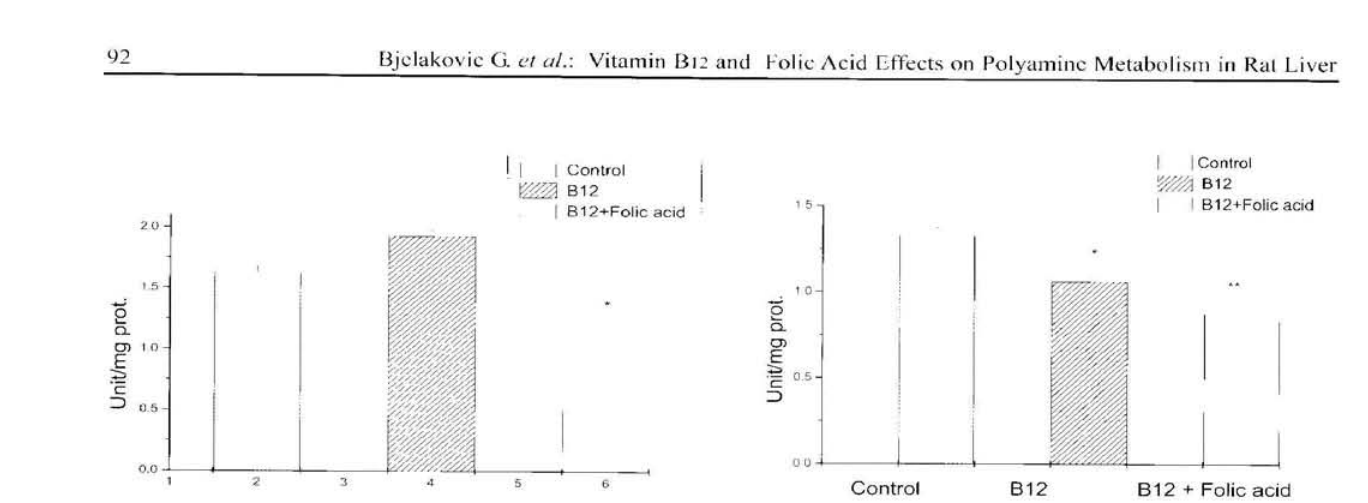
Figure 2. Polyaminc oxidase activity in liver tissue of rats treated with B12 and folic acid. Vitamin Bi: in a single daily dose of 0.5 nig / animal i.m. during seven days. The second experimental group received vitamin B12 (in the same dose) plus folic acid (2.5 mg/animal) during seven days. Control group received 0.9 % NaCl instead of vitamins; *p <0.05 compared to controls)